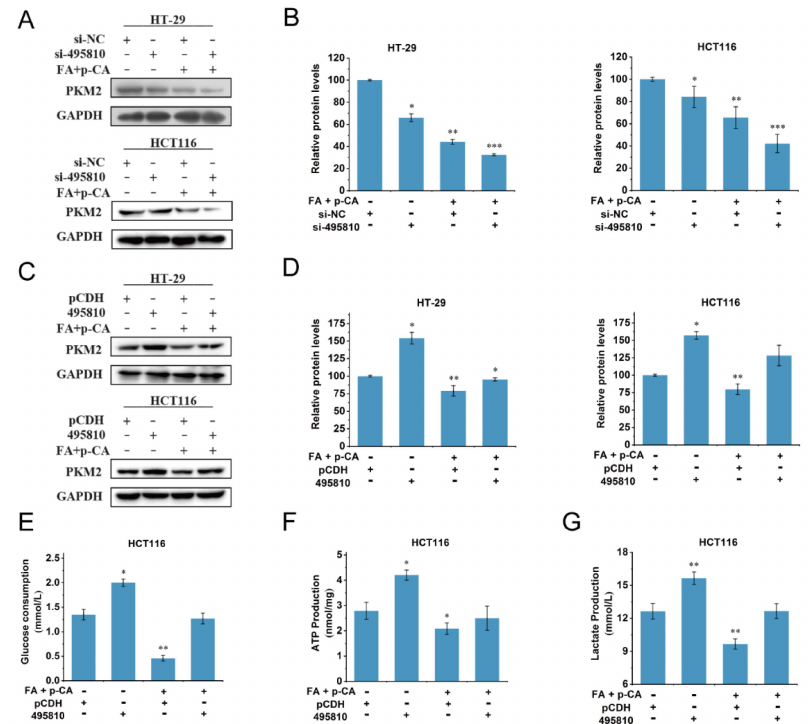
Figure 5. LncRNA 495810/PKM2 axis is involved in the inhibition effect of FA + pCA on the aerobic glycolysis. ( A , B ) At 24 h post-transfection with si-NC or si-495810, HT-29 and HCT116 cells were treated with 120 µ g/mL FA + p-CA for another 48 h, the expression of PKM2 protein was checked by western blot ( A ). The densitometry analysis of relative protein expression ( B ). ( C , D ) At 24 h post-transfection with pCDH or 495810, HT-29 and HCT116 cells were treated with 120 µ g/mL FA + p-CA for another 48 h. The expression of PKM2 protein was determined by western blot ( C ). The densitometry analysis of relative protein expression ( D ). ( E – G ) At 24 h post-transfection with pCDH or 495810, HT-29 and HCT116 cells were treated with 120 µ g/mL FA + p-CA for another 48 h, glucose consumption ( E ), ATP generation ( F ) and lactate production ( G ) were discovered. Data are represented as means ± SD ( n ≥ 5). * p < 0.05, ** p < 0.01, *** p <